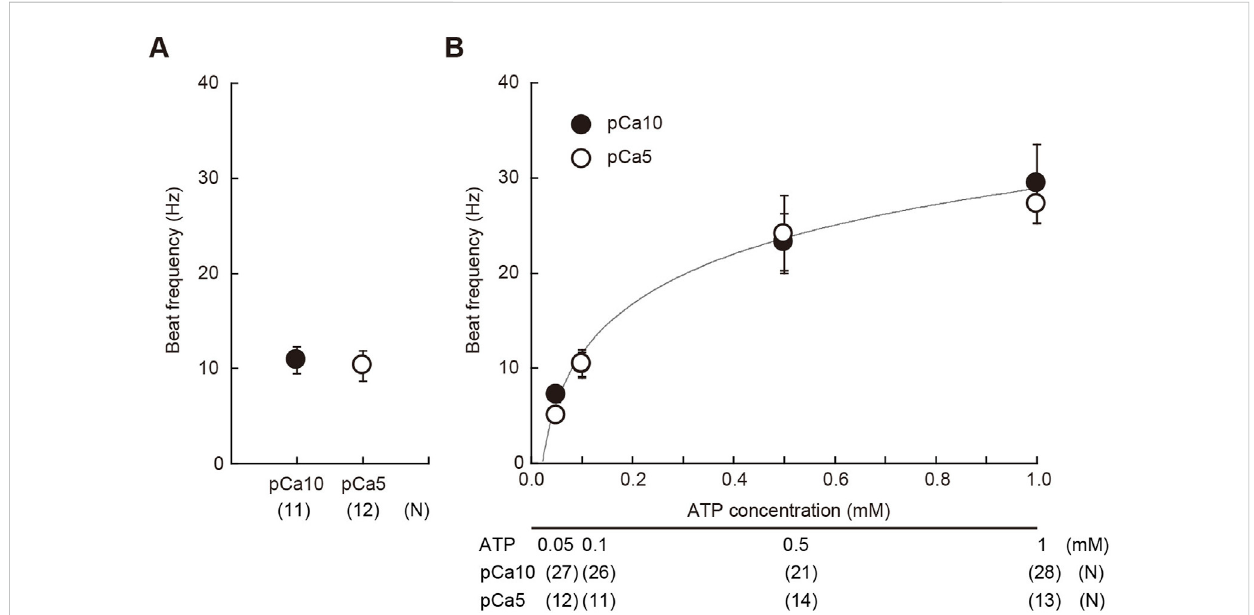
FIGURE 1 Estimation of the concentration of ATP released from caged ATP. (A) Beat frequency of demembranated Ciona sperm incubated with 1 mM caged ATP and reactivated by a 150 ms UV fl ash. N = 11 (pCa10), and N = 12 (pCa5). (B) Beat frequency of demembranated and reactivated Ciona sperm by various concentrations of Mg-ATP in the absence of caged ATP. Closed and open circles show Ca 2+ concentrations in the reactivation solutions at pCa10 and pCa5, respectively. N = 13 – 28 from three different experiments. Values are expressed as mean ±